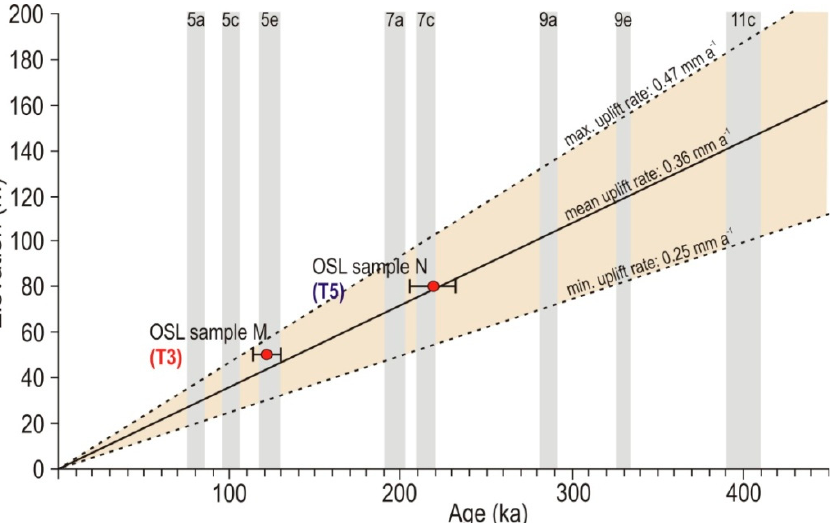
Figure 7. Correlation diagram of the two OSL dated samples, collected from marine terraces T3 and T5, respectively, with late Quaternary MIS. Gray vertical bands correspond to the age extent of the different sea-level highstands (from Lisiecki and Raymo [88]). Mean, maximum, and minimum uplift rates from this correlation are also shown.